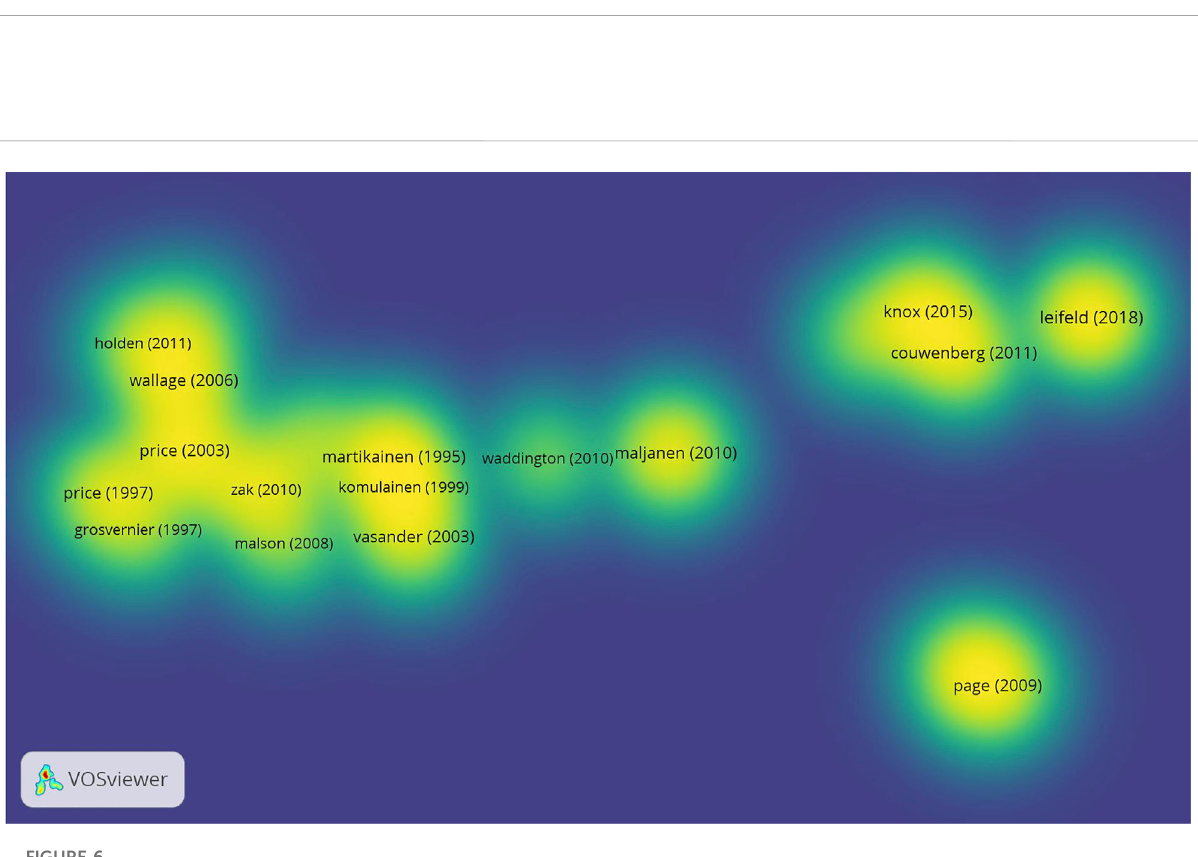
FIGURE 6 Density map of document citation network